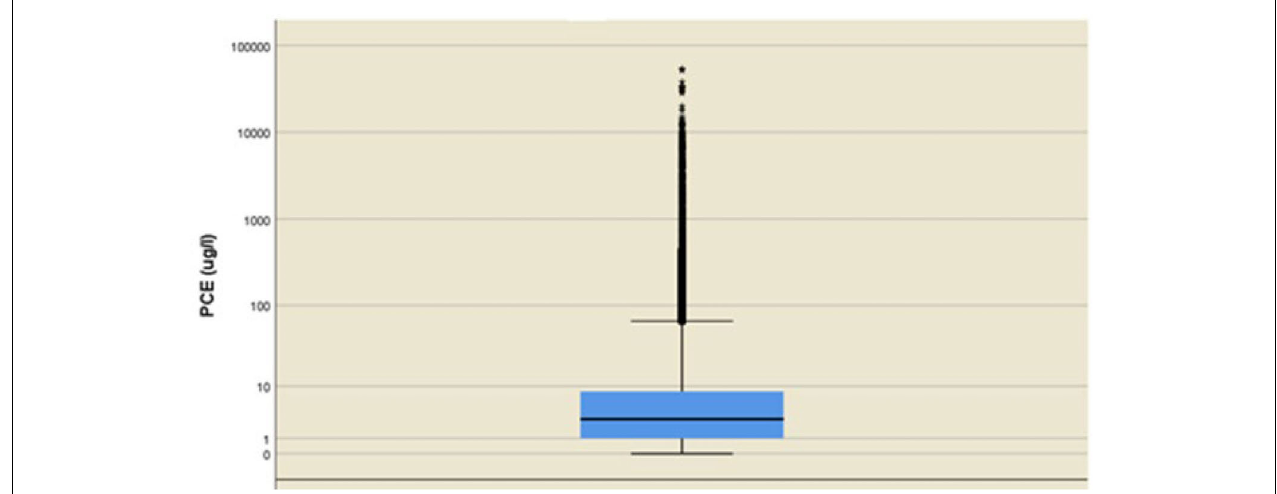
FIGURE 5 | Boxplot in a logarithmic scale of the distribution of the 48,316 PCE measurements ( µ g/L). Mild outliers (i.e., points beyond the inner fences) are drawn as dots, whereas extreme outliers (i.e., points beyond the outer fences) are drawn as